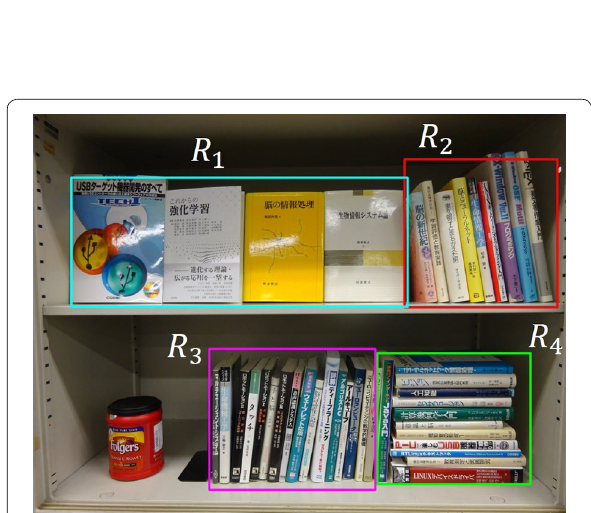
Fig. 13 Extraction results for the area of a group of regularly arranged